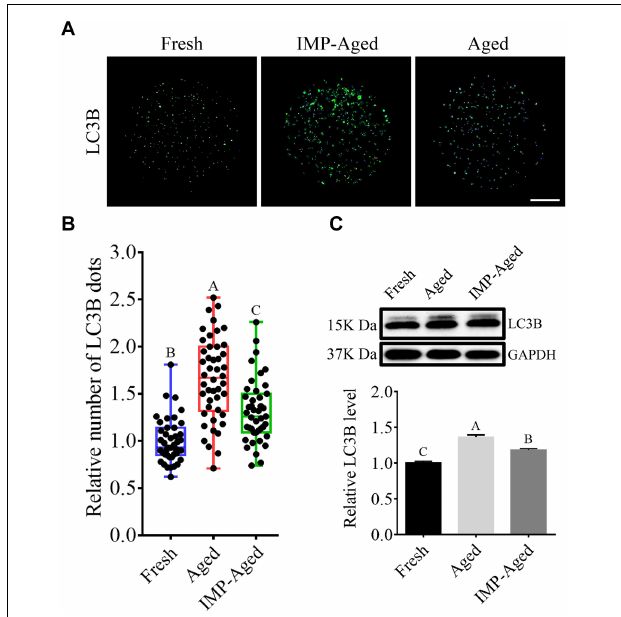
FIGURE 6 | IMP supplementation reduced autophagy in aged oocytes. (A) Representative immunofluorescent images of LC3B dots in fresh, aged, and IMP-treated aged oocytes. Scale bar = 25 µ m. (B) The relative number of LC3B dots in fresh ( N = 43), aged (N = 44), and IMP-treated aged oocytes ( N = 42). R = 4. (C) Expression of LC3B in fresh, aged, and IMP-treated aged oocytes. R = 3.